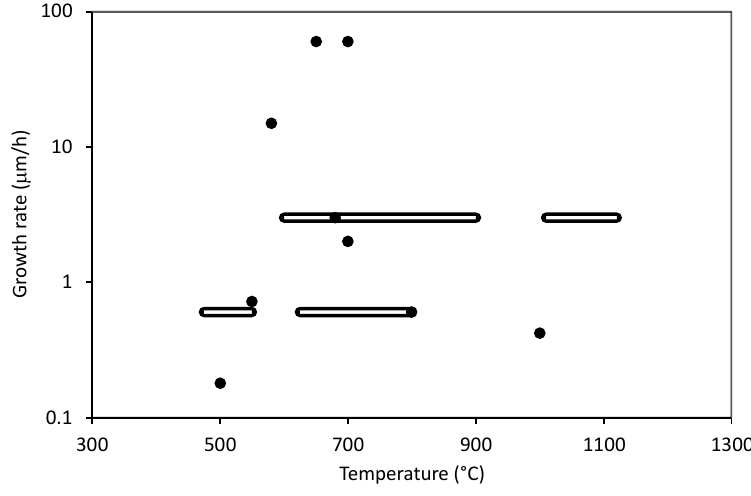
Figure 4. The growth rate versus the temperature as reported in literature shown in Table 1. The dots represent results in the cases when the authors performed experiments at a constant temperature. Some authors reported a range of temperatures during deposition—these results are represented with longitudinal bars.